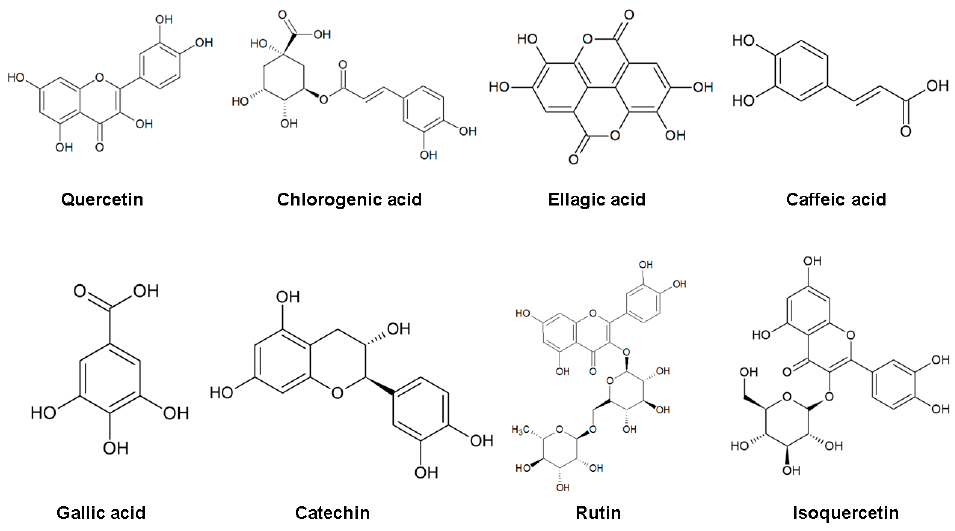
Figure 1. Chemical structure of the main bioactive compounds of the Spondias genus. Figure was created by authors using ChemSketch 1.